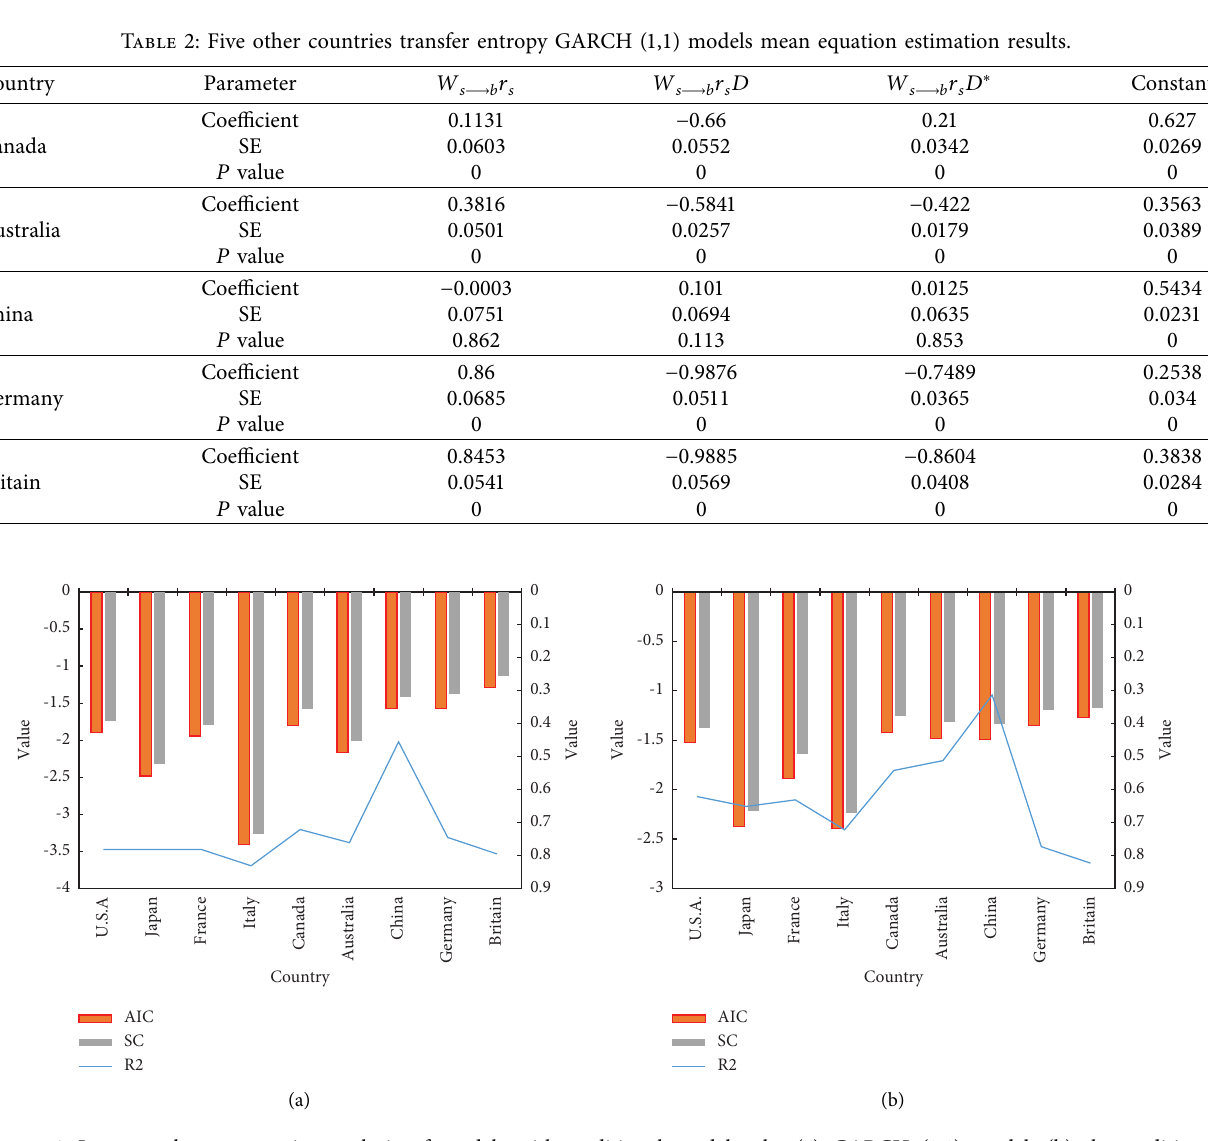
Figure 6: Improve the comparative analysis of models with traditional models: the (a) GARCH (1,1) model; (b) the traditional GARCH